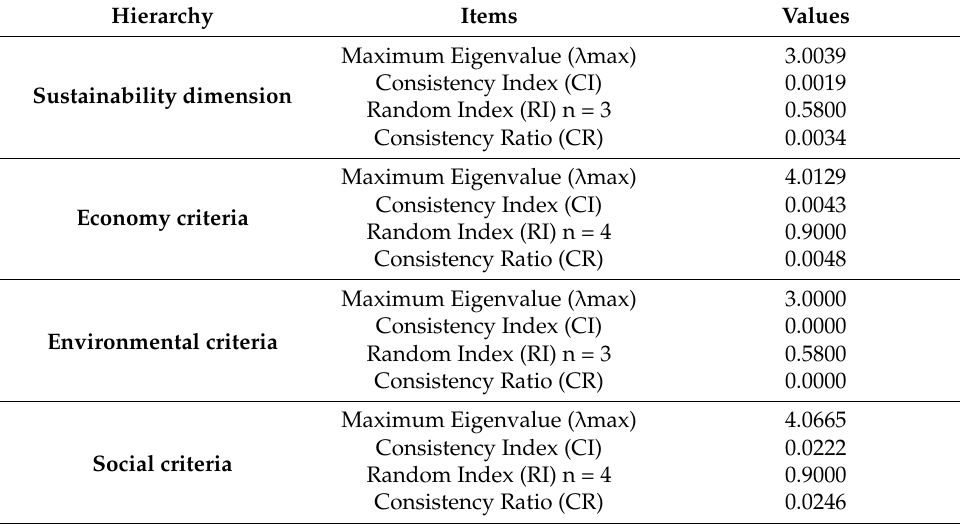
Table 5. Consistency computation for each pairwise comparison